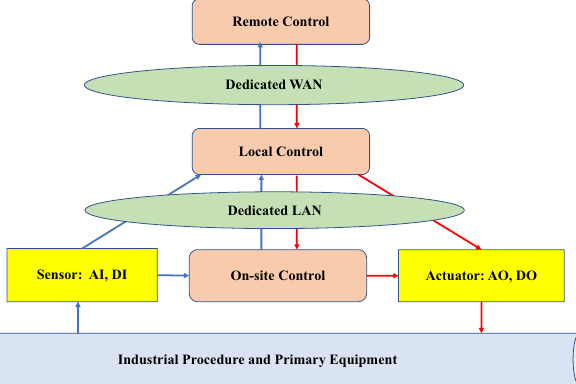
Figure 1. Abstract model of industrial control